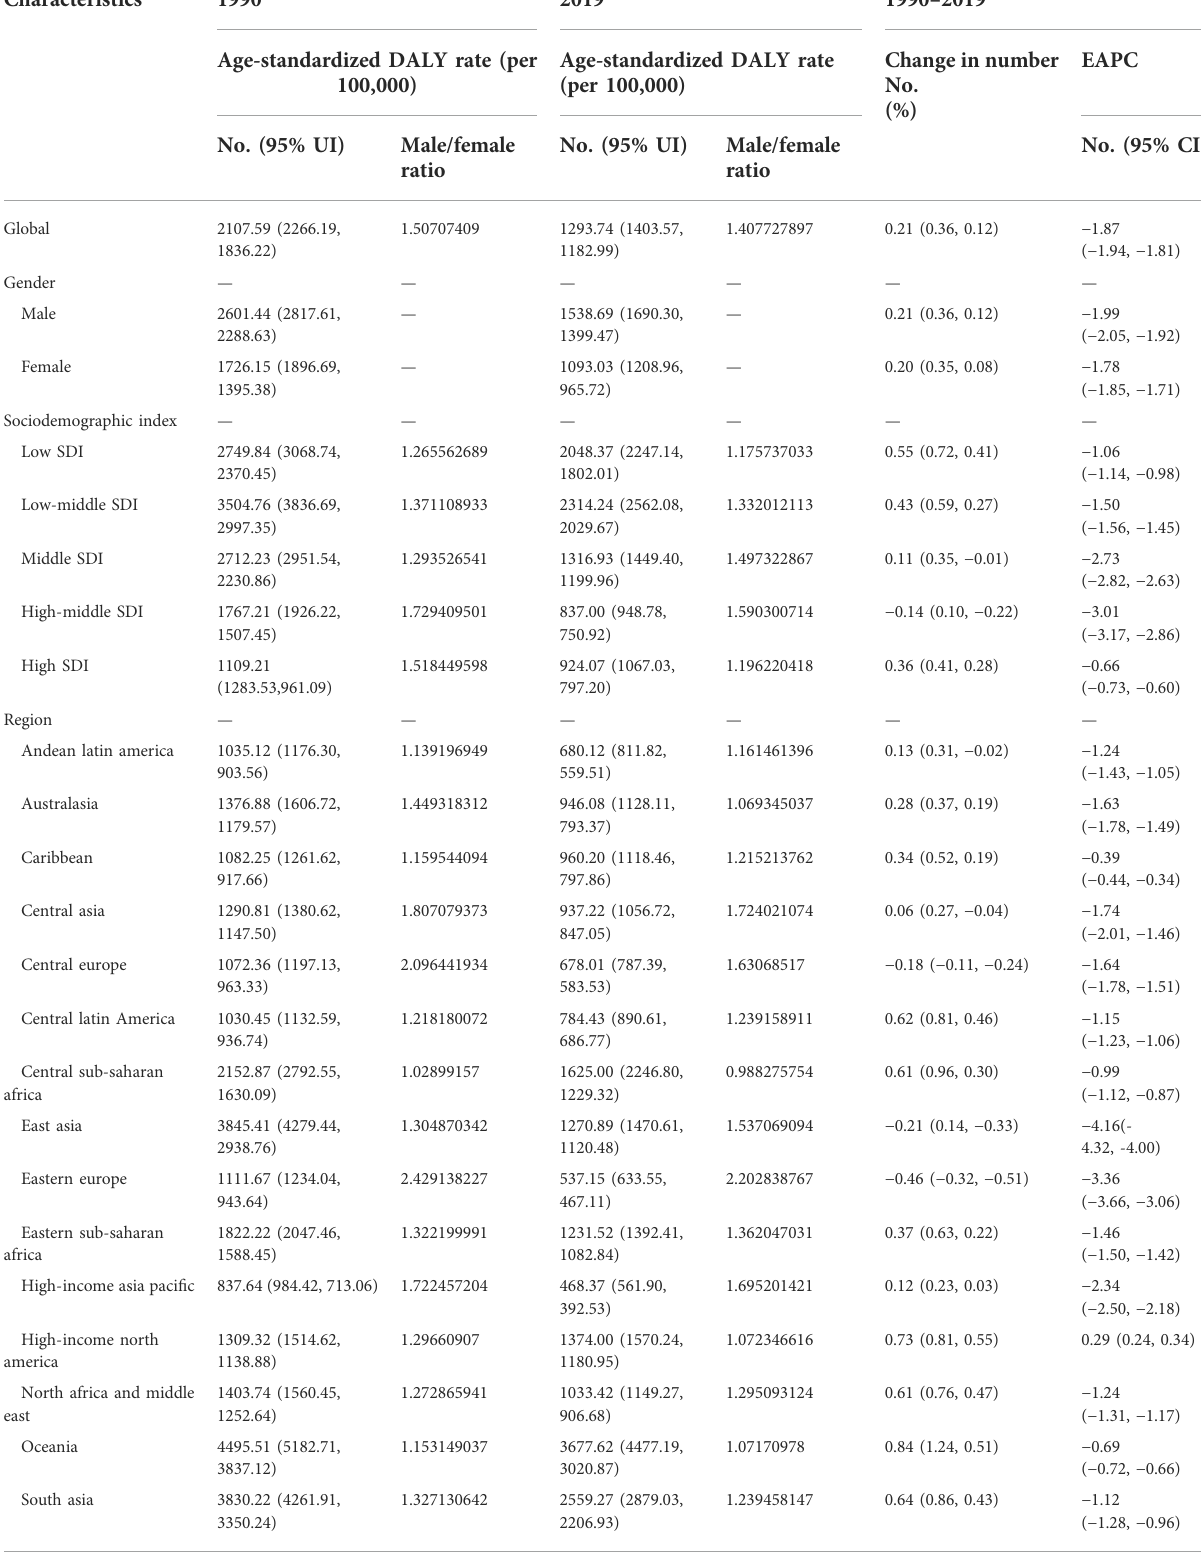
TABLE 3 The age-standardized DALY rate of chronic obstructive pulmonary disease in 1990 – 2019 and its temporal trends.